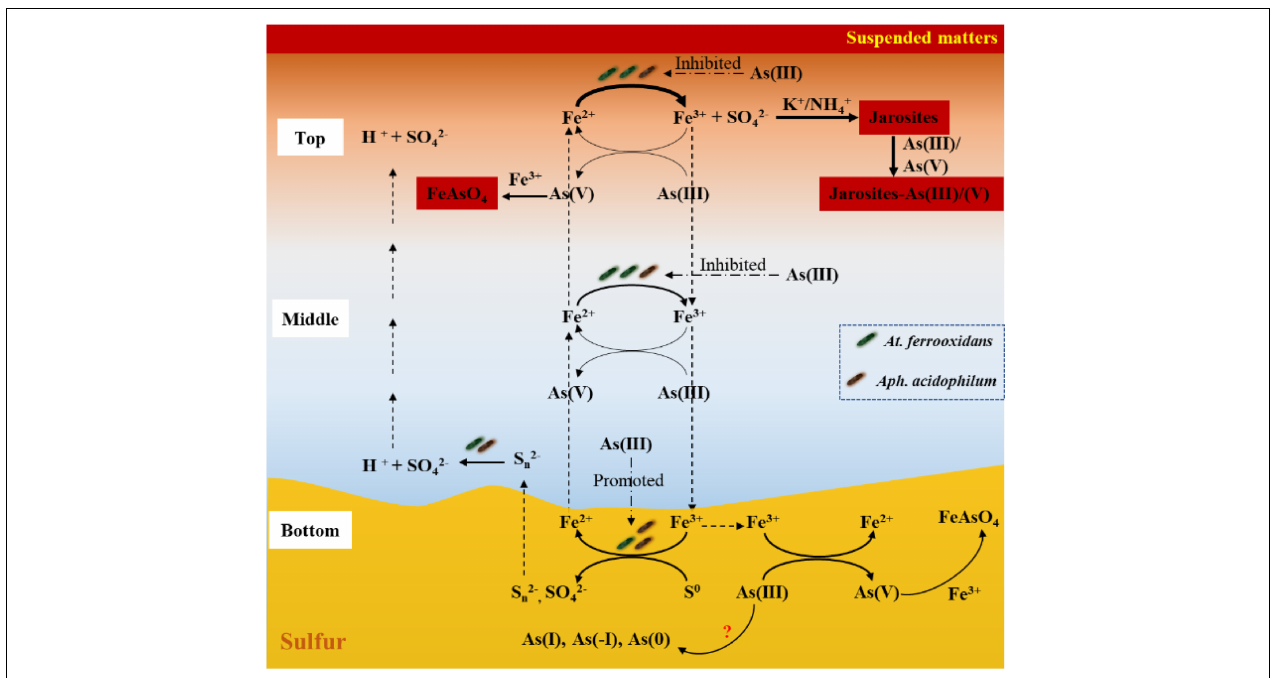
FIGURE 8 | The diagram of the correlation between Fe/S/As speciation transformation and bacterial ( At. ferrooxidans and Aph. acidophilum ) depth distribution under different depths of the acidic water column. Dashed arrows show the migration of the dissolved ions, and solid arrows show the Fe/S/As redox reactions.